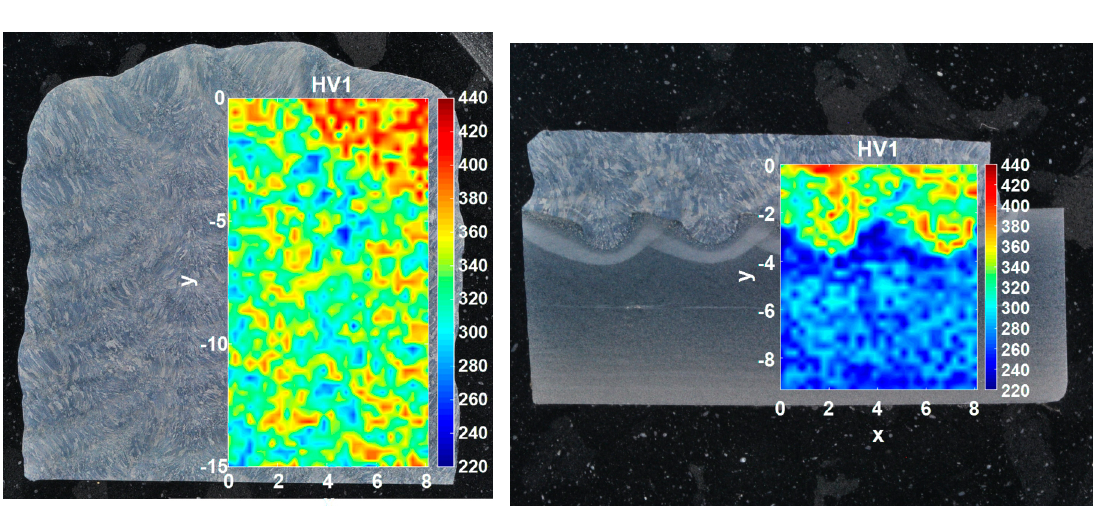
Figure 11. Hardness mapping for the top- and bottom-section. The colormap shows interpolated local Vickers hardness values (HV1) for the given xy -position.